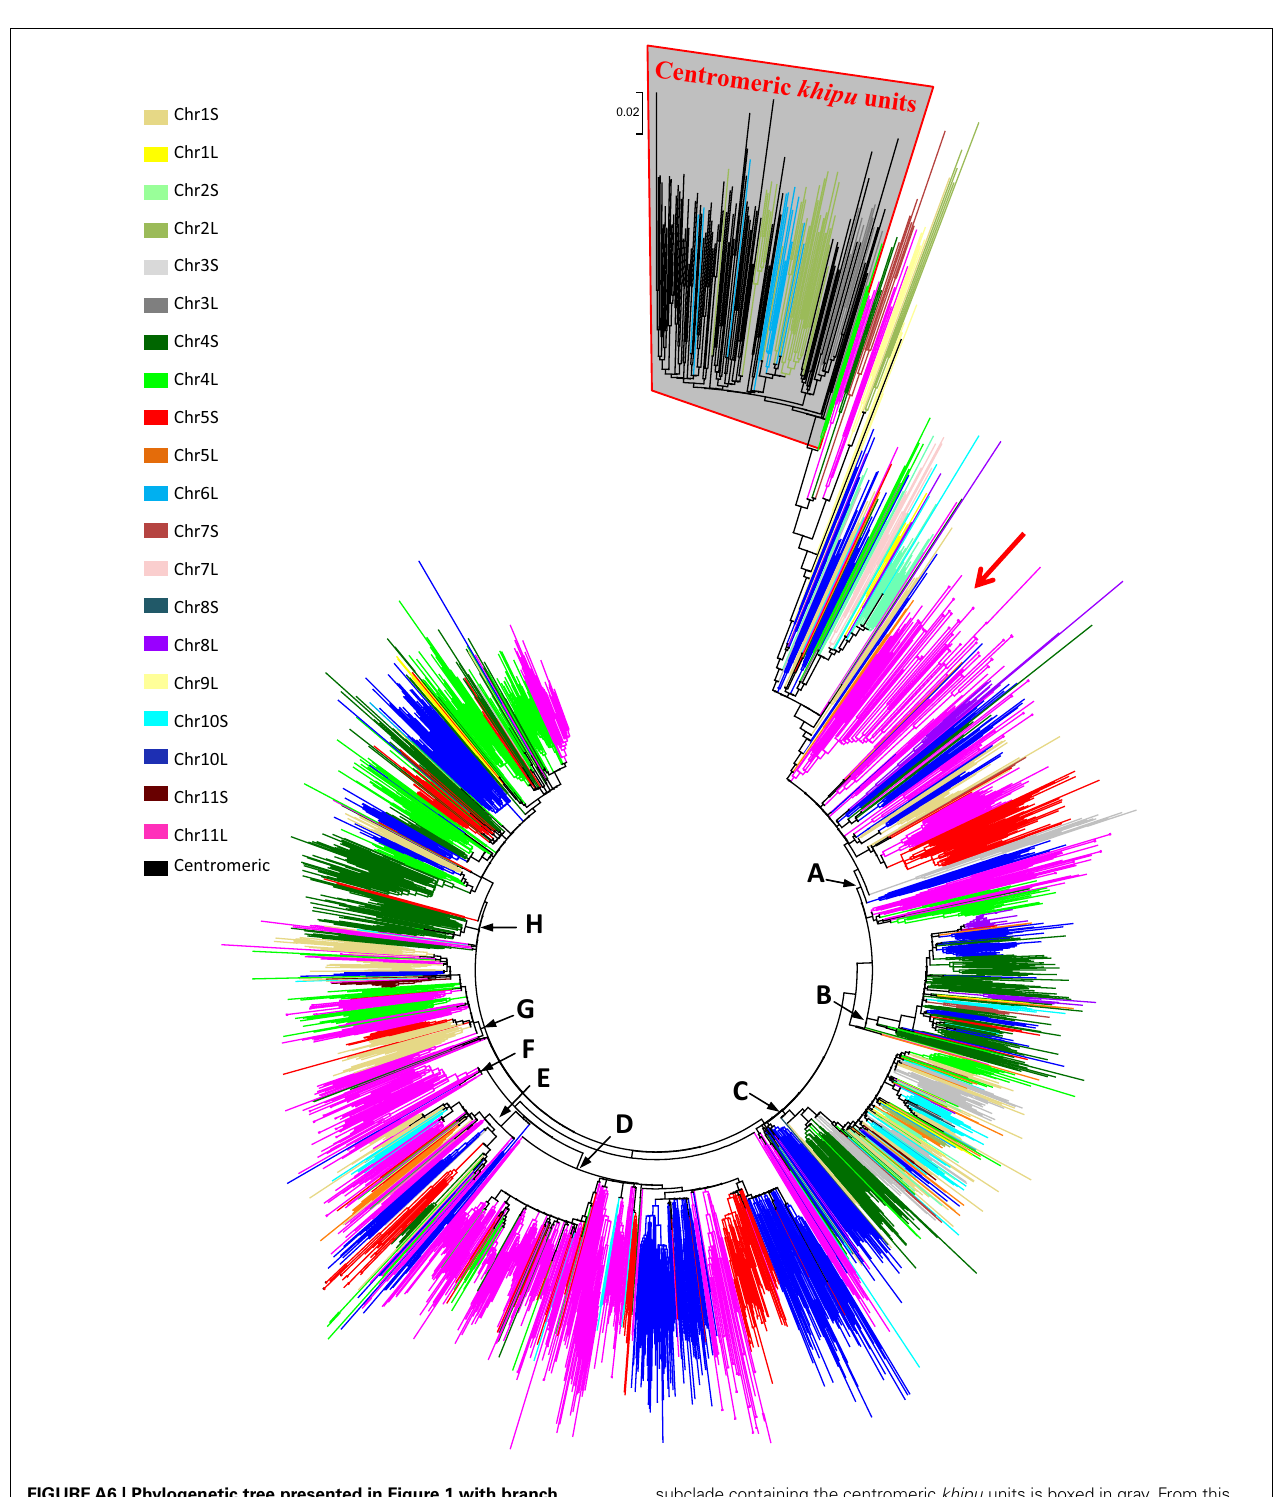
FIGUREA6 | Phylogenetic tree presented in Figure 1 with branch length . Clade names (A–H) correspond to the clades defined in Figure 1 and branch colors correspond to the colors defined in Figure 1 .The